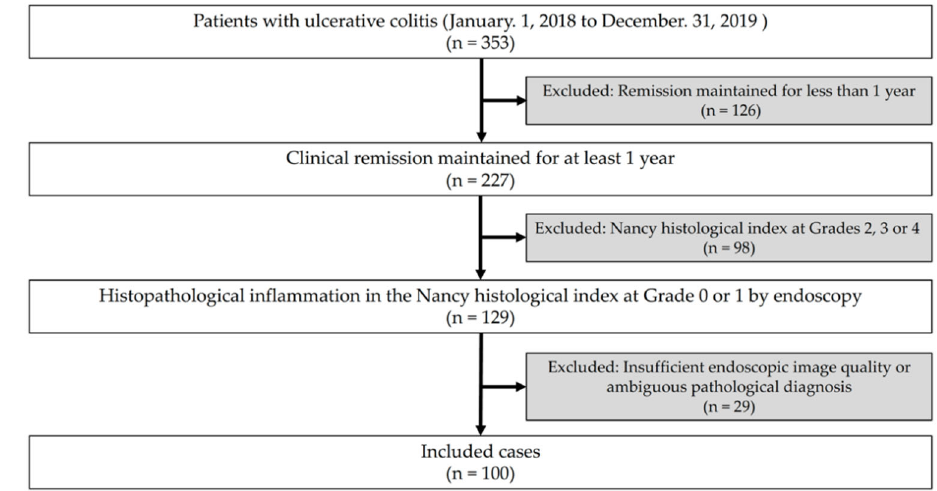
Figure 1. Flow diagram of this study.